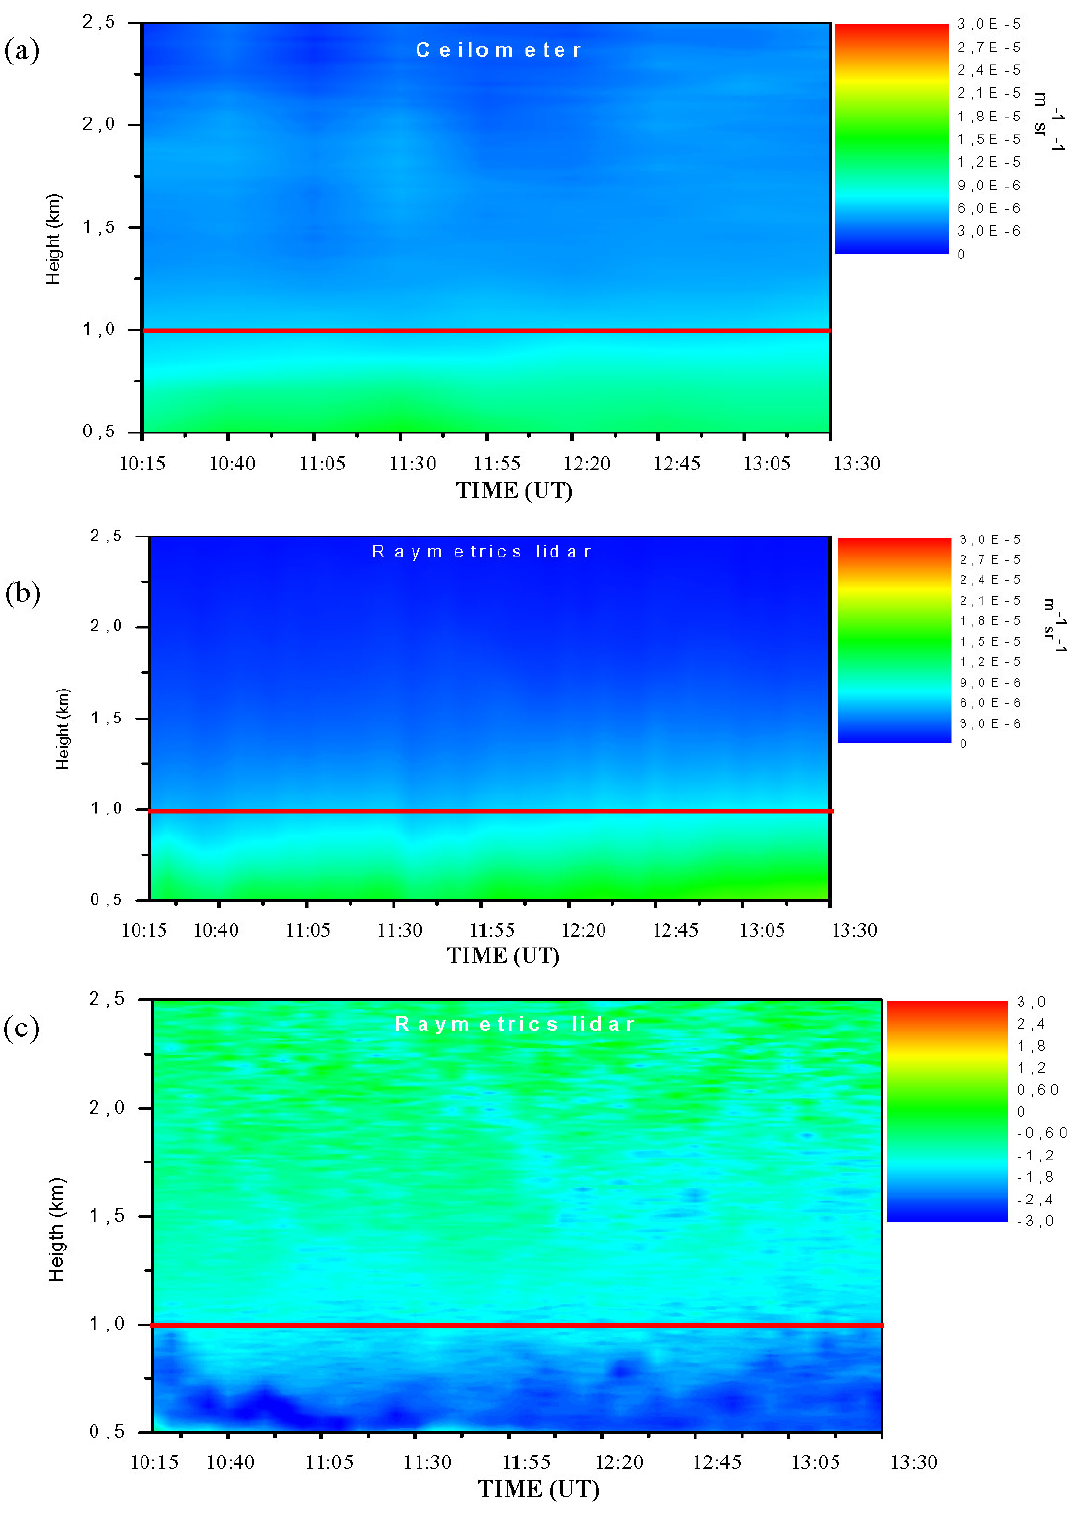
Fig. 1. Attenuated backscatter coefficient (in m − 1 sr − 1 ) obtained (a) by the ceilometer and (b) the Raymetrics lidar. (c) The first derivative of the logarithm of the range-corrected lidar signal (in arbitrary units: A.U.) obtained by the Raymetrics system. Time height cross sections are valid from 10:15UT to 13:30UT on 26 November 2008. Red lines represent mean PBL height around